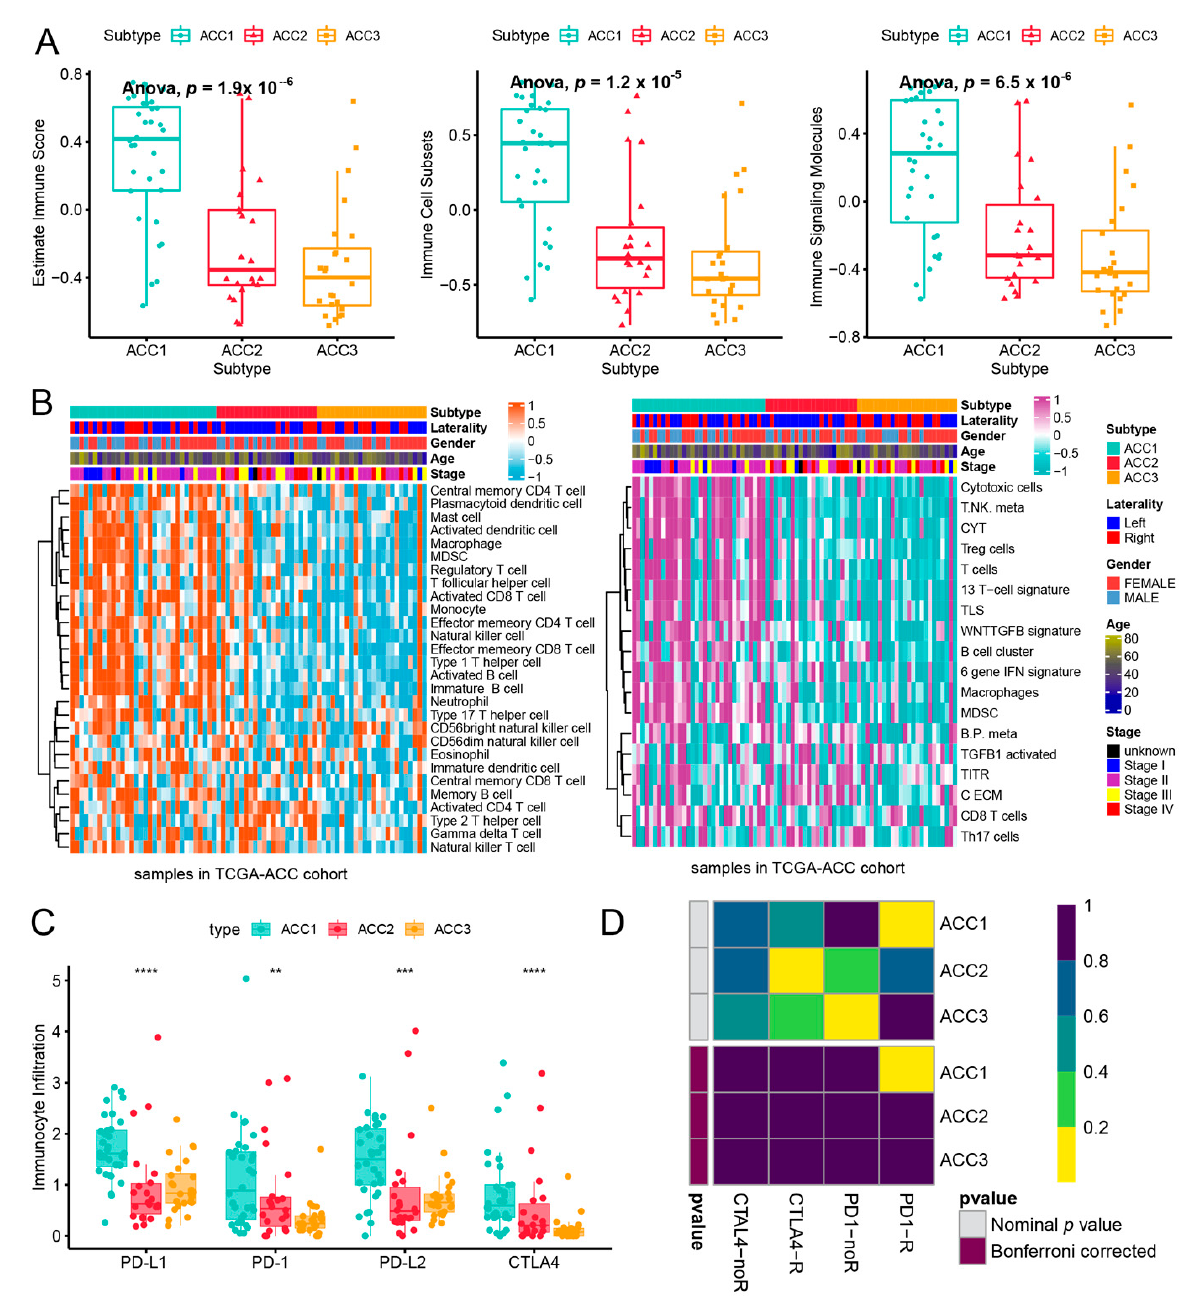
Figure 5. Differences of immune infiltration in three ACC subtypes. ( a ) Score of related indicators of immune infiltration. ( b ) Heatmap of infiltration landscape of different immune cells between the three subtypes. ( c ) Expression of the three subtypes to PD-L1 and PD-1. ( d ) SubMap analysis of anti-PD-L1 therapy. ** p < 0.01, *** p < 0.001, **** p <